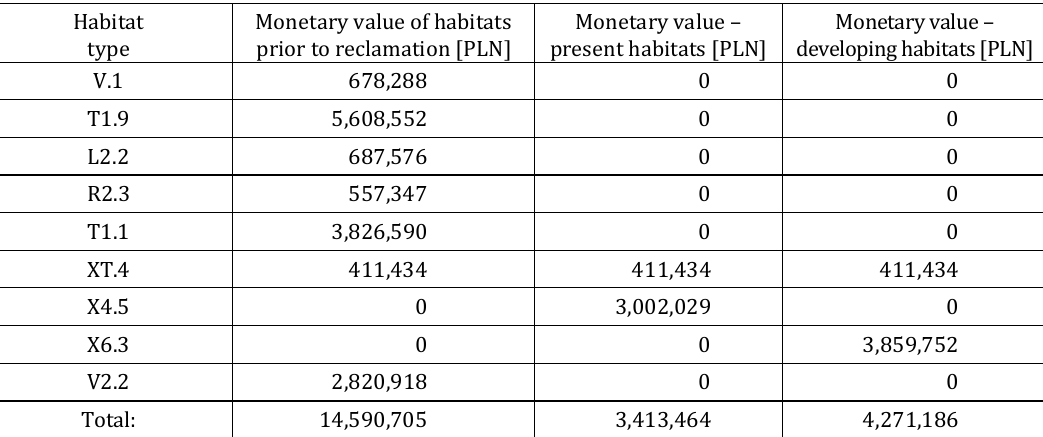
Table 5. Monetary values for particular